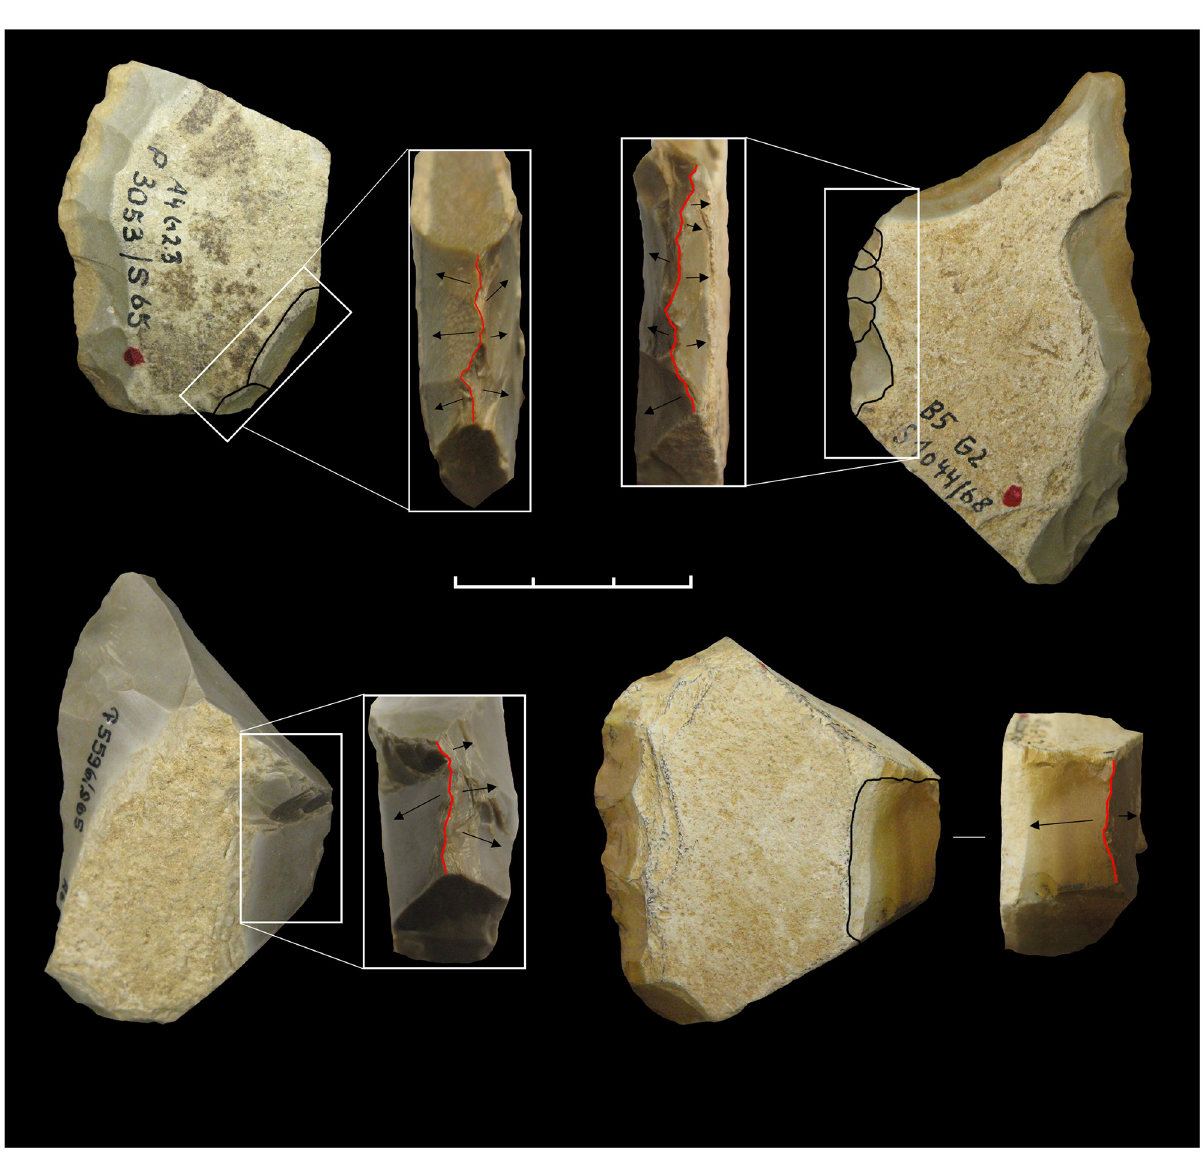
Fig 10. Keilmesser and scrapers showing bifacial or unifacial detachments on the conjunction between the backed portions. From the top left: P3053/S65; S1044/S68; P5596/S65; S5234/70.